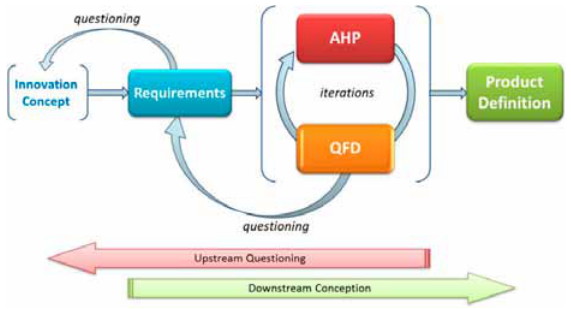
Fig. 2. The iterative AHP-QFD-AHP